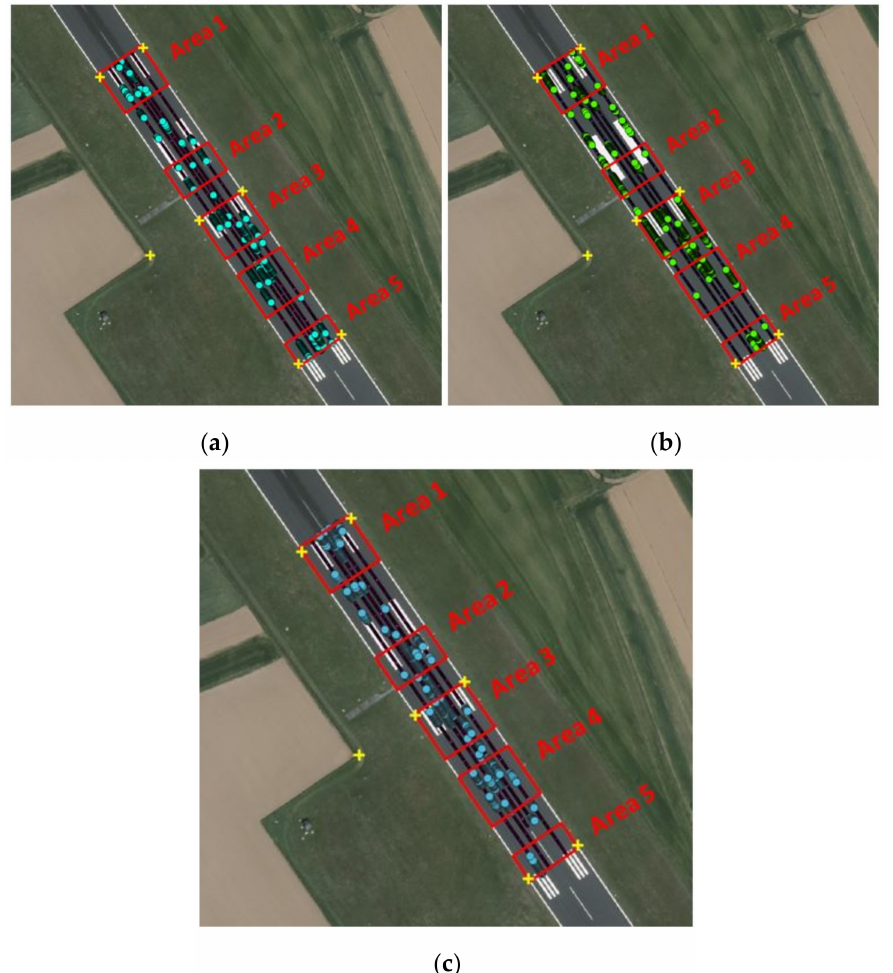
Figure 11. Areas of maximum vertical deviations in the ( a ) first, ( b ) second, and ( c ) third periods of